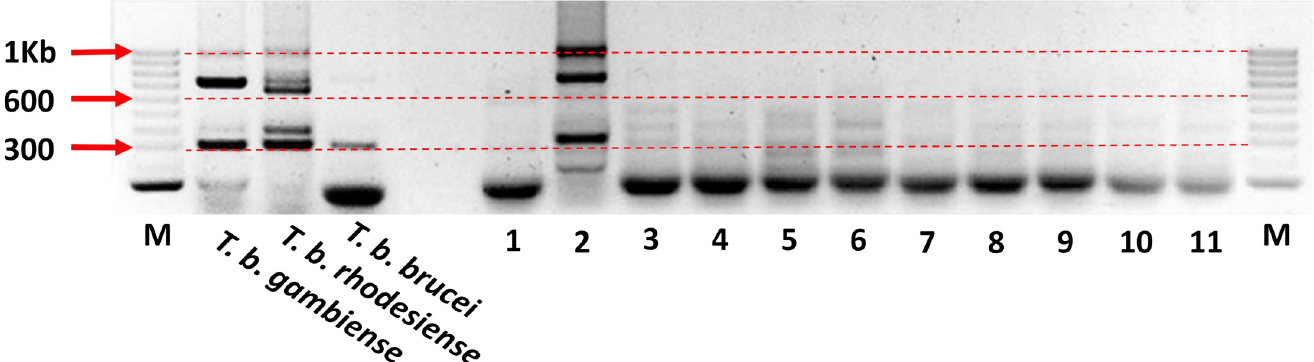
Fig 4. Example of gel run showing the results of the sub-species Trypanozoon multiplex PCR. The 324bp PLC product can be seen in the three positive controls and in sample number 2. The 669bp SRA product can be seen in the T . b . rhodesiense positive control but is absent from the other T . brucei sub-species. A > 1 kb VSG product is visible in sample 2 and is faintly visible in the T . b . rhodesiense positive control. A fourth product of ~700 bp can also be seen in the T . b . gambiense and T . b . rhodesiense positive controls as well as sample 2.